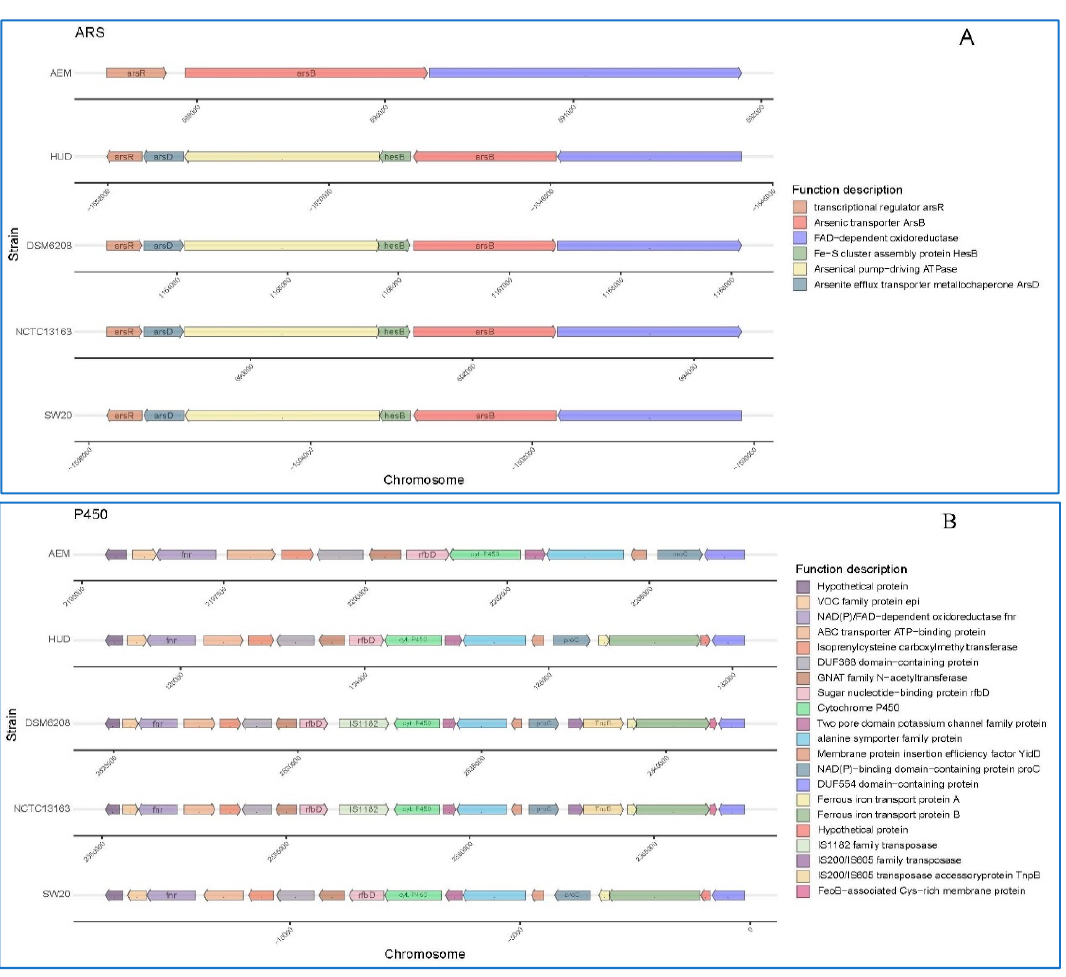
Figure 5. Cont Fig 5 . Schematic comparison of the three main gene clusters for different function based on annotations in the KEEG database: ( A ) Arsenic tolerance ( B ) Cytochrome P450 hydroxylase and ( C ) Na + /H + antiporter protein in E. aurantiacum SW-20, E. aurantiacum DSM 6208, E. aurantiacum NCTC13163, E . mexicanum A-EM and E . mexicanum HUD.